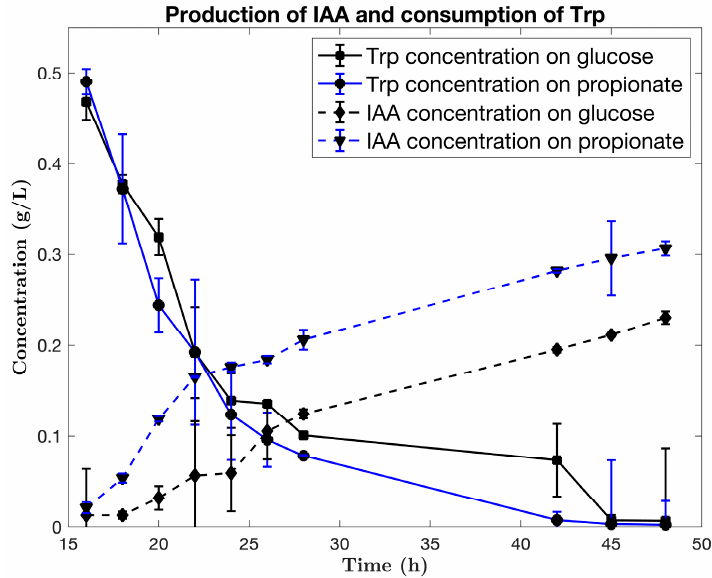
Figure 2. Kinetics of tryptophan consumption and IAA production using glucose and propionate as carbon source.